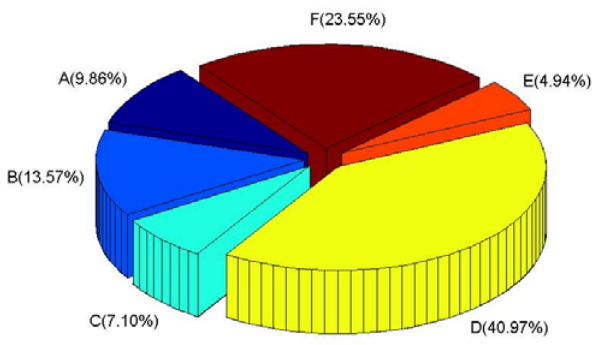
Figure 2. Distributions of atmospheric